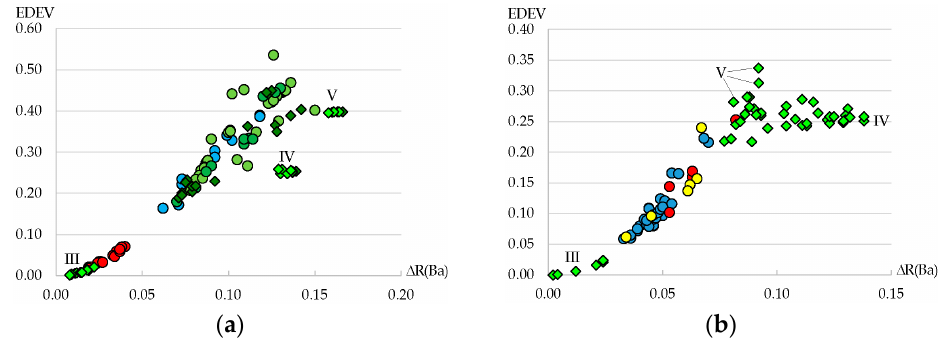
Figure 9. Correlations between EDEV X and Baur distortion index— ∆ R ( Ba ) for ( a ) Pb–chabourn é ite (Biagioni et al. [7]) and ( b ) argentoliveingite (Topa et al. [16]). Blue circles denote Pb, red circles represent Tl ( a ) or Ag ( b ); light − green circles in ( a ) are Sb positions, dark − green diamonds are mixed As–Sb positions, yellow circles are mixed Pb–As sites and light green diamonds are pure As positions. Roman numerals denote the coordination of As.